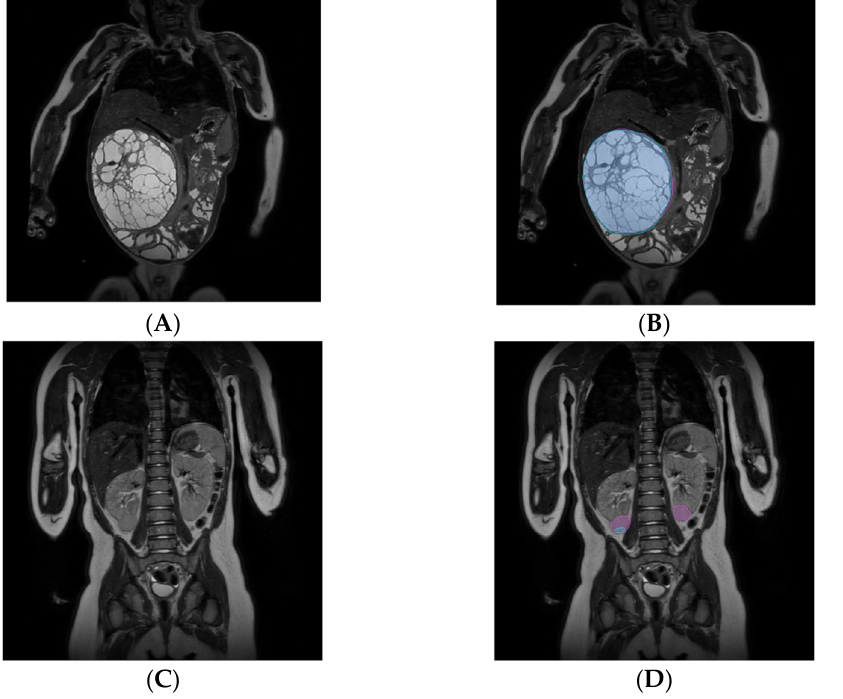
Figure 4. Examples of automated Wilms tumor segmentation. Patients with the highest Dice score (top row (( A ): MRI, ( B ): MRI with measurements; Dice score = 0.97) and the lowest overall Dice score (bo tt om row (( C ): MRI, ( D ) MRI with measurements; Dice score = 0.26 for the right kidney tumor, Dice score = 0 for the left kidney tumor as it was missed). The reference manual segmentation is shown in purple, and the deep learning segmentation is projected on the manual segmentation in blue. Note that in ( B ) these regions have an almost complete overlap.